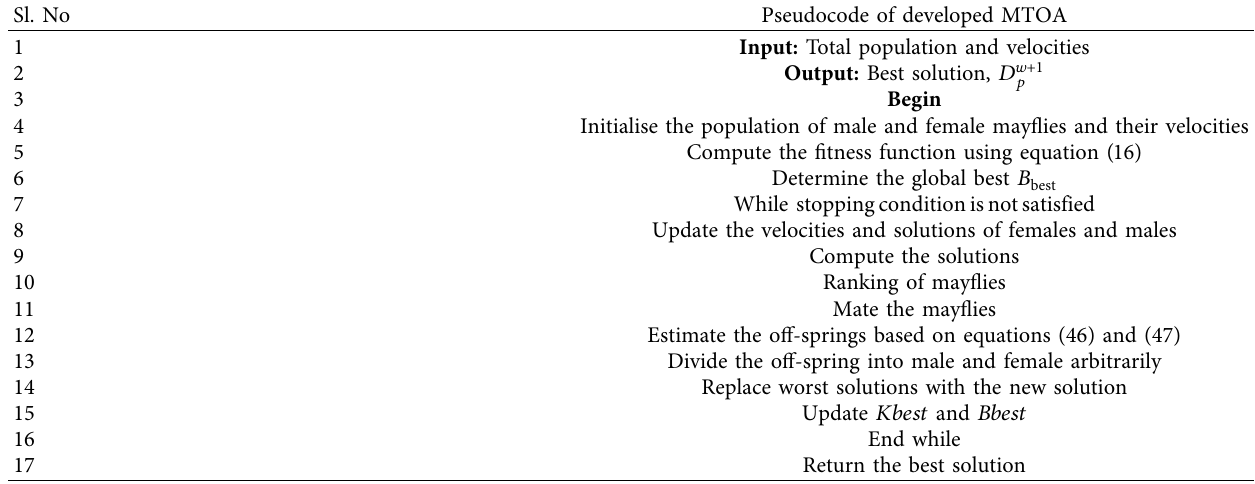
Table 3: Pseudocode of devised